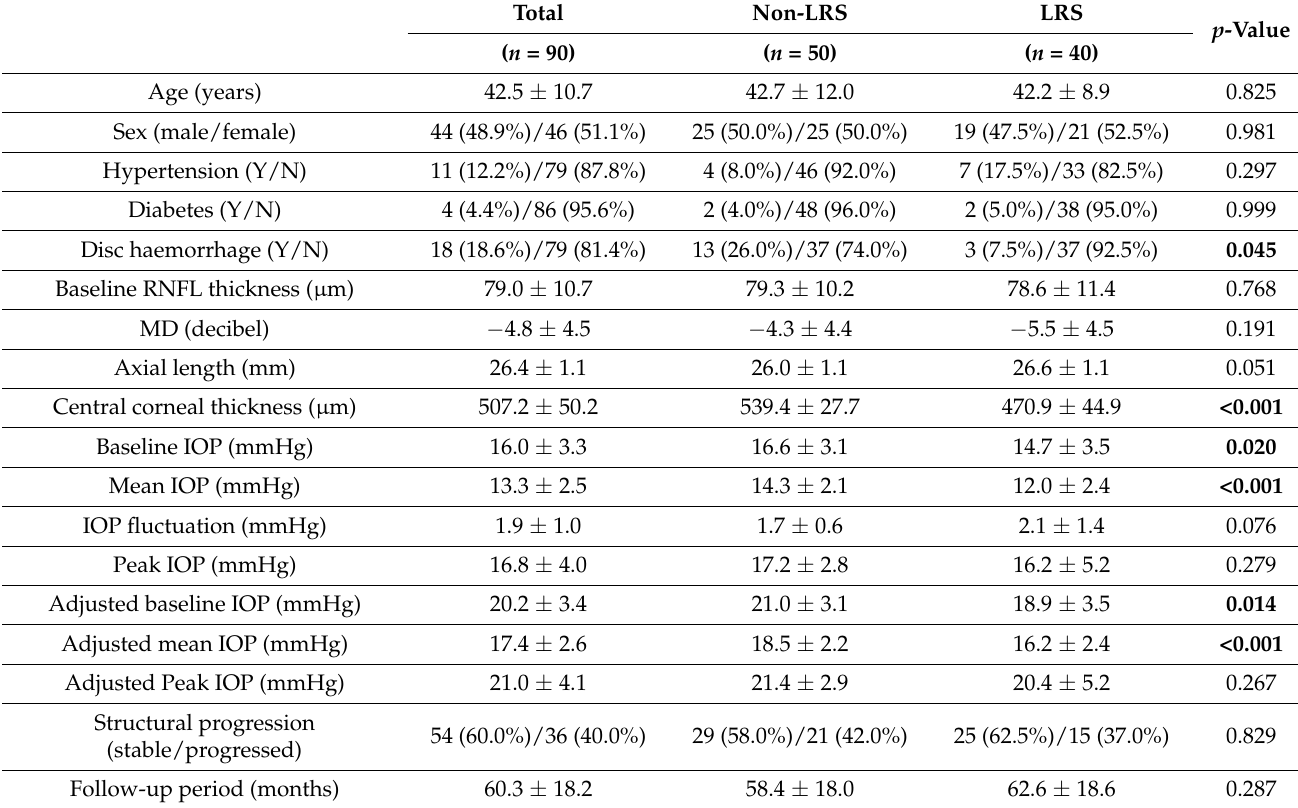
Table 1. Demographic characteristics.